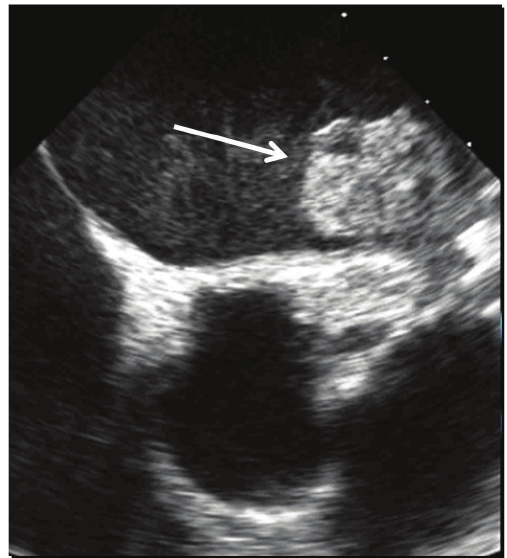
Figure 5: Transesophageal echocardiographic image of a large thrombus (arrow) on a WATCHMAN device several months after anticoagulation was discontinued.